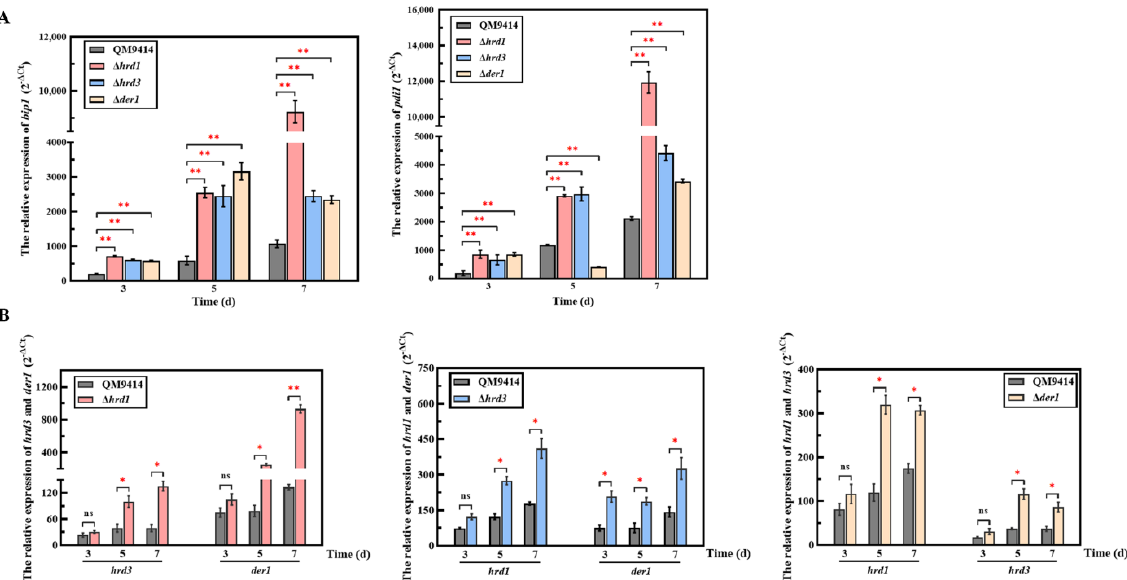
Figure 5. The ER pressure of the ERAD-deficient mutants under cellulase-induced secretion conditions. ( A ) The relative transcription levels of UPR-related genes bip1 and pdi1 in the ERAD-deficient mutants under cellulase-induced secretion conditions. ( B ) The relative transcription levels of hrd1 / hrd3 / der1 in the ERAD-deficient mutants under cellulase-induced secretion conditions. Cellulase induction medium contained 2% microcrystalline cellulose and 2% corn steep liquor, which promotes the production of large amounts of cellulase. The relative transcription level of each gene was calculated by the qPCR results of the fermentation samples on the 3rd, 5th, and 7th days. Actin gene was universally used to normalize gene transcription levels. Values represent the mean of three repeated measurements taken from at least three parallel experiments. The error bars refer to the standard deviations. The difference between the parental strain and the knockout strains was shown by analysis of ANOVA followed by Tukey’s test. * p < 0.05; ** p < 0.01. ns, not significant.